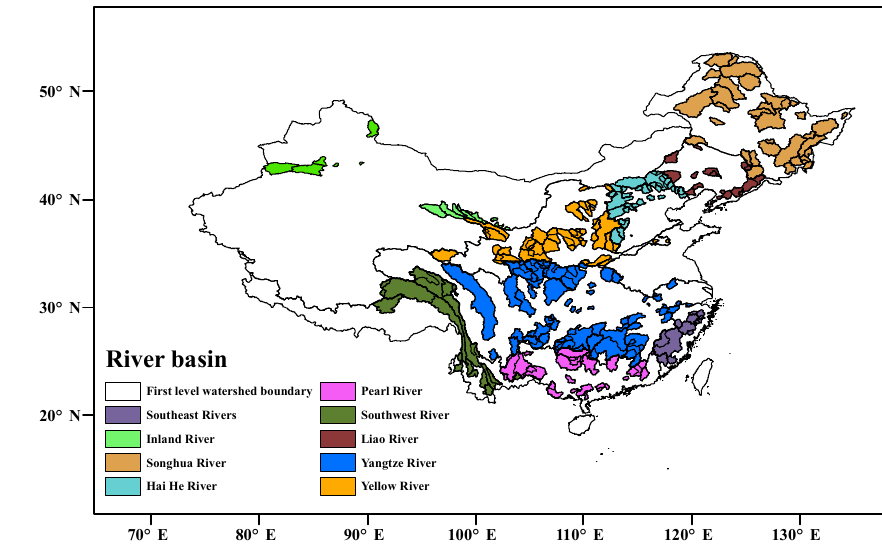
Figure 1. Spatial distribution of the 291 study catchments across mainland